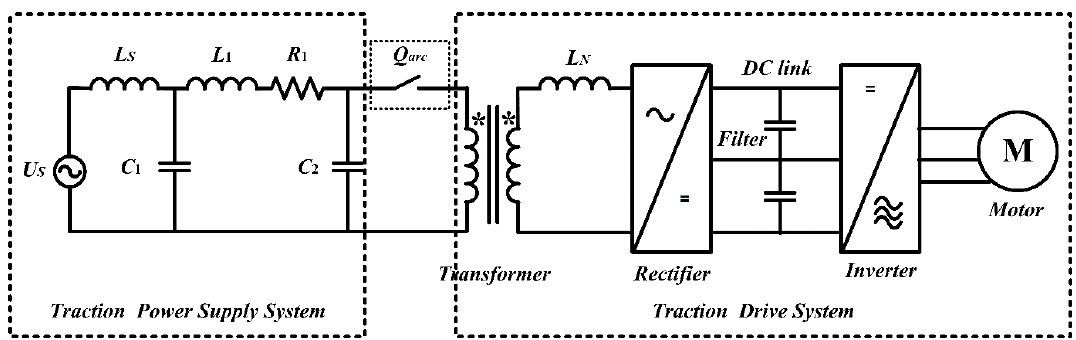
Figure 1. The structure of the traction system [25].